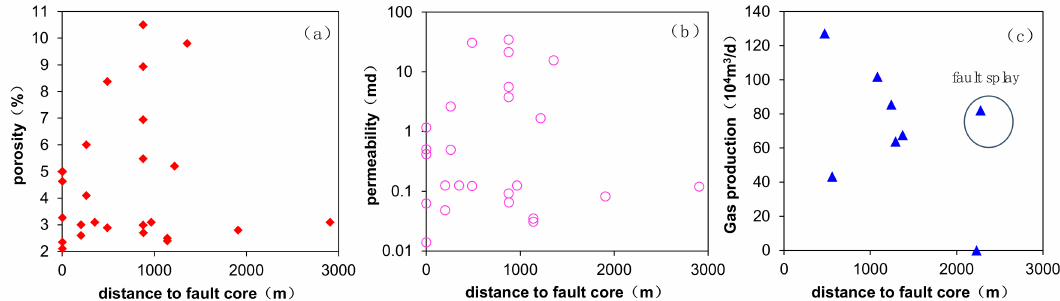
Figure 5. Porosity ( a ), permeability ( b ), and gas production ( c ) vs. distance to the fault in the Permian